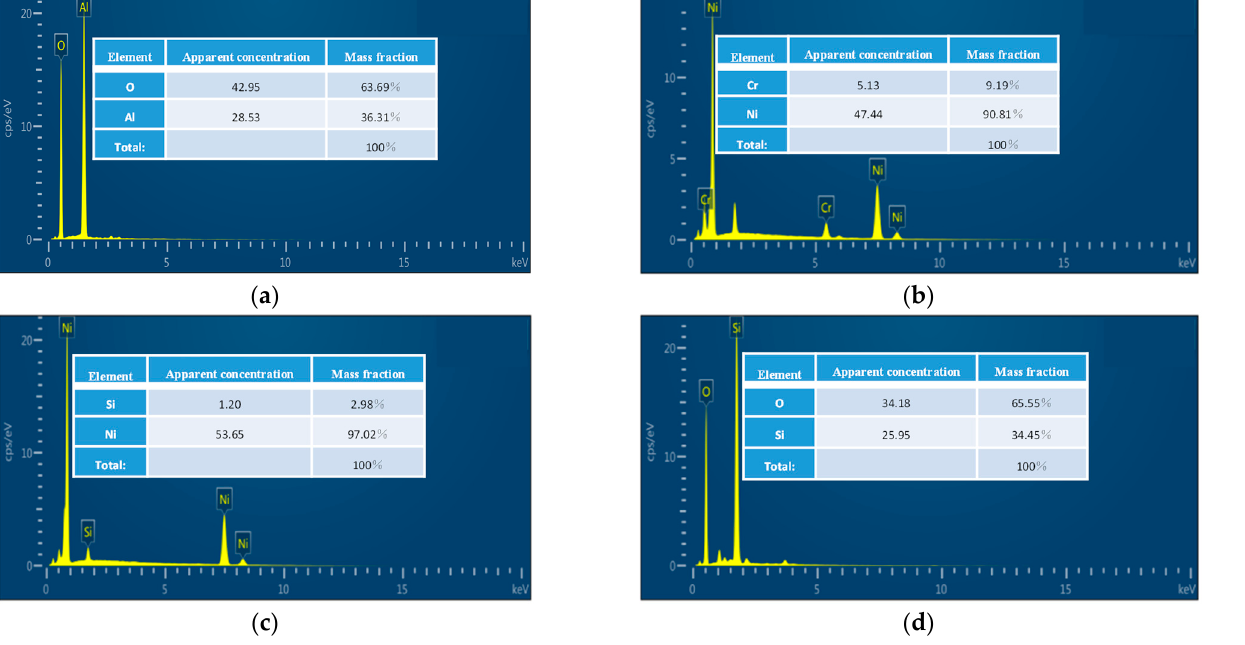
Figure 8. Energy spectrum analysis of thin films: ( a ) Al 2 O 3 thin films; ( b ) NiCr thin films; ( c ) NiSi thin films; ( d ) SiO 2 thin films.